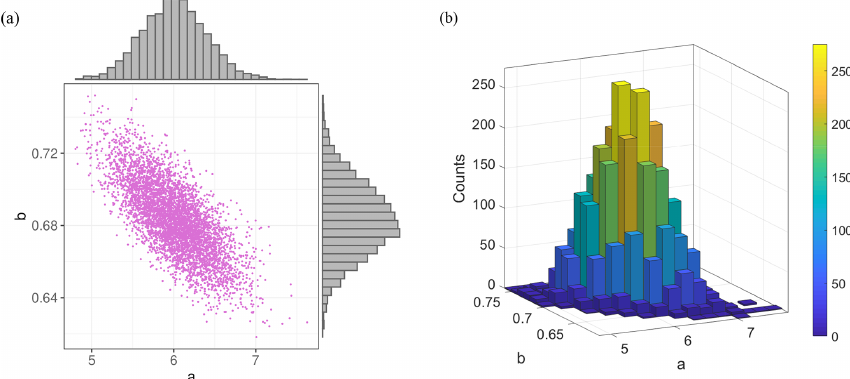
Figure 10. Values a and b of Eq. (12) obtained performing 5000 MC simulations: (a) scatter plot and histogram and (b) 3 D histogram.